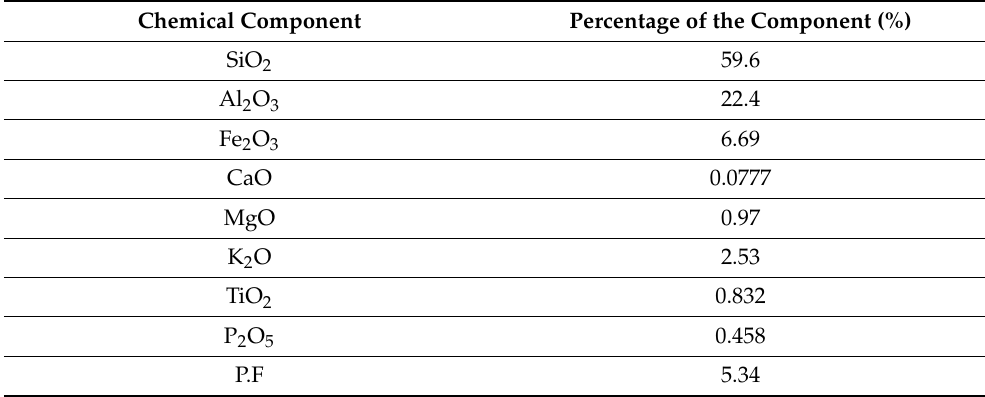
Table 1. Chemical analysis of Bensmim clay using X-ray